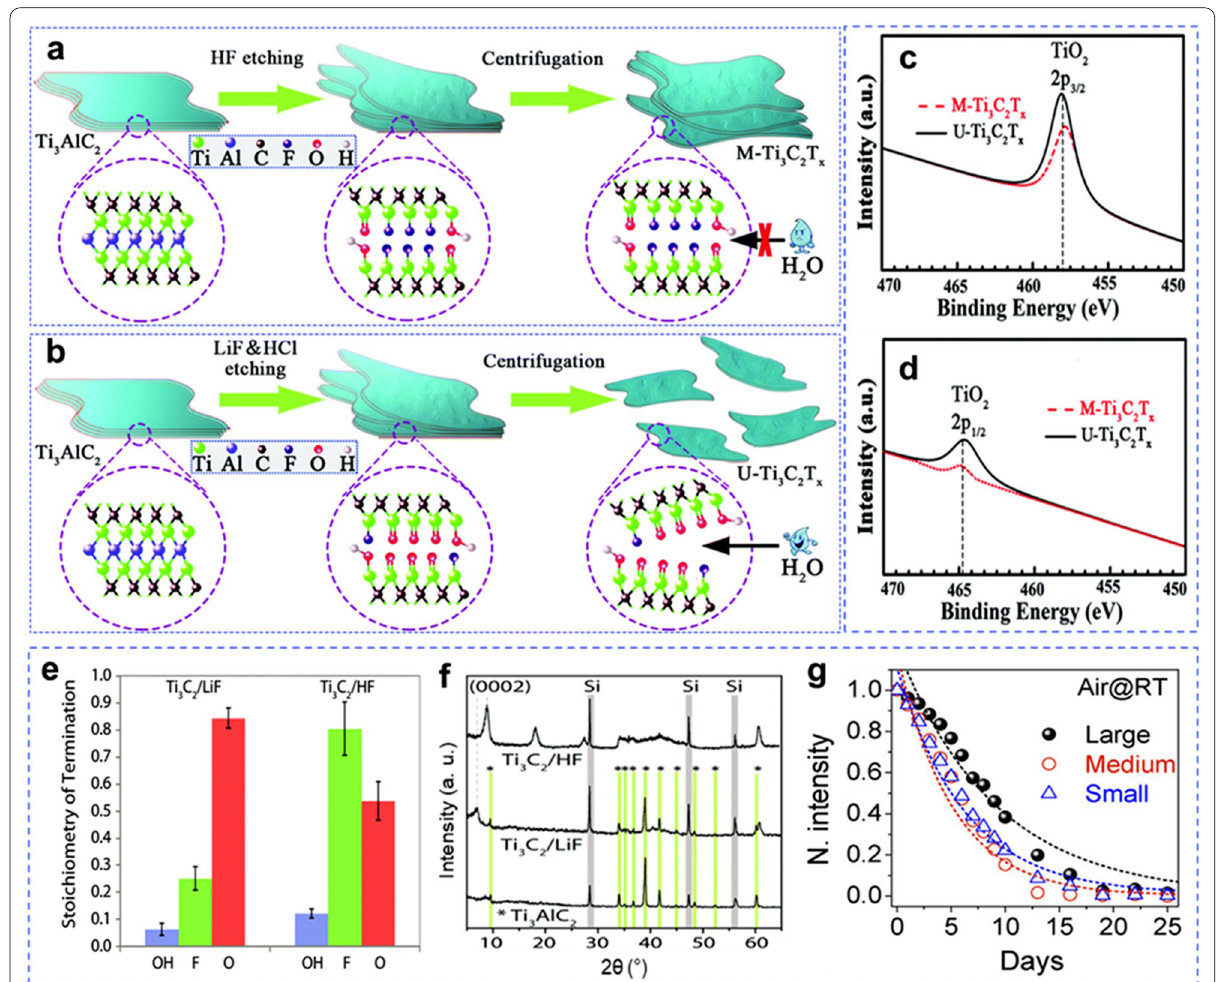
Fig. 5 Synthetic illustration of a M-Ti 3 C 2 T x , and b U-Ti 3 C 2 T x MXenes. Comparison of component peak-fitting of XPS spectra for M-Ti 3 C 2 T x , and U-Ti 3 C 2 T x Ti2p at c TiO 2 2p 3/2 , and d TiO 2 2p 1/2 . e Composition of the Ti 3 C 2 T x surface functional groups produced by etching of the Ti 3 AlC 2 in HF and LiF–HCl solutions, per